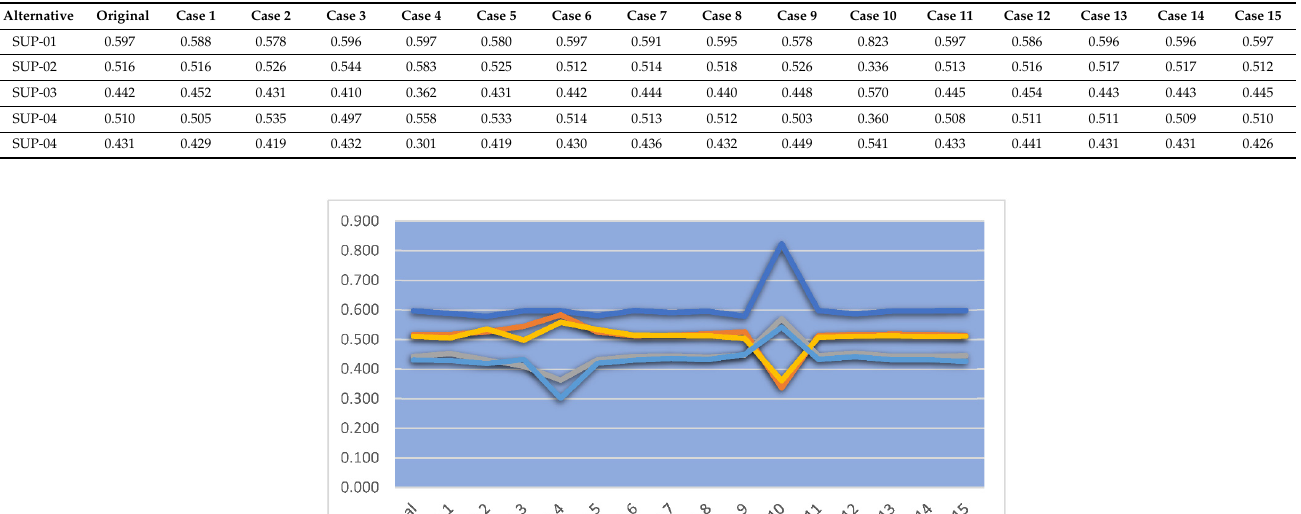
Table 7. Performance results in all cases.